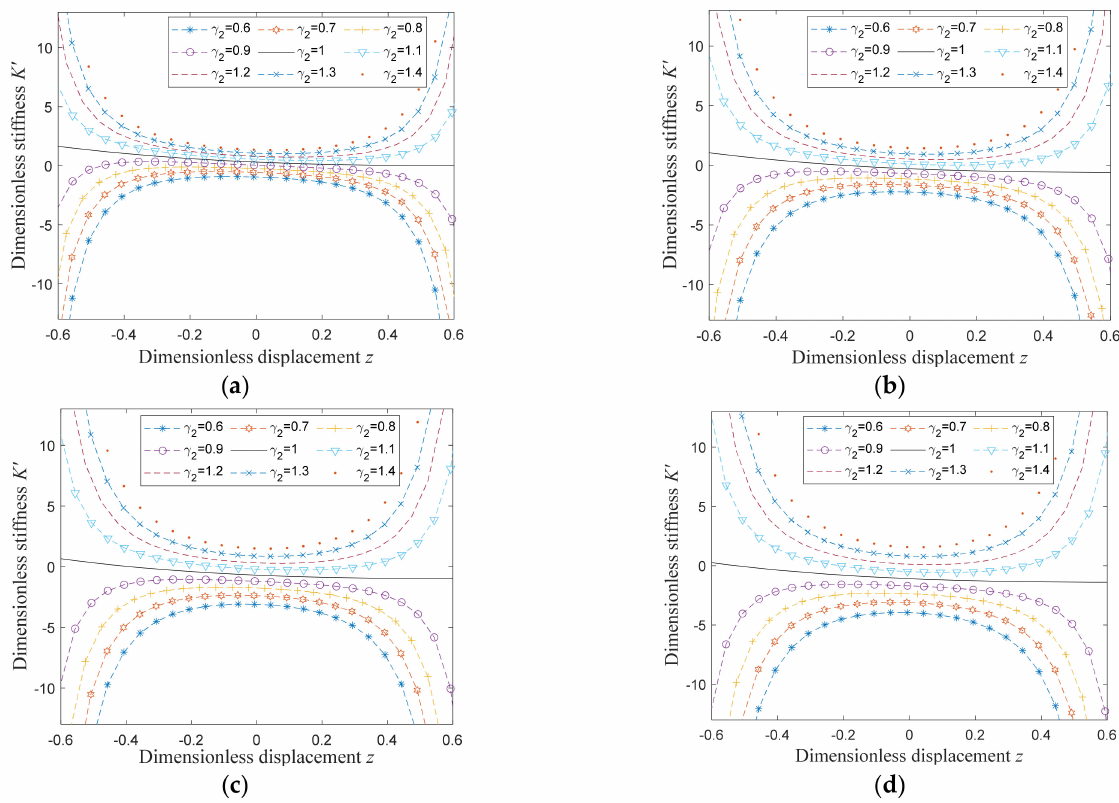
Figure 7. Dynamic stiffness curves of systems with the various values of γ 2 (z = H (cid:48) − x (cid:48) ): ( a ) α = 0.5, γ 1 = 0.8; ( b ) α = 0.8, γ 1 = 0.8; ( c ) α = 1, γ 1 = 0.8; ( d ) α = 1.2, γ 1 = 0.8.